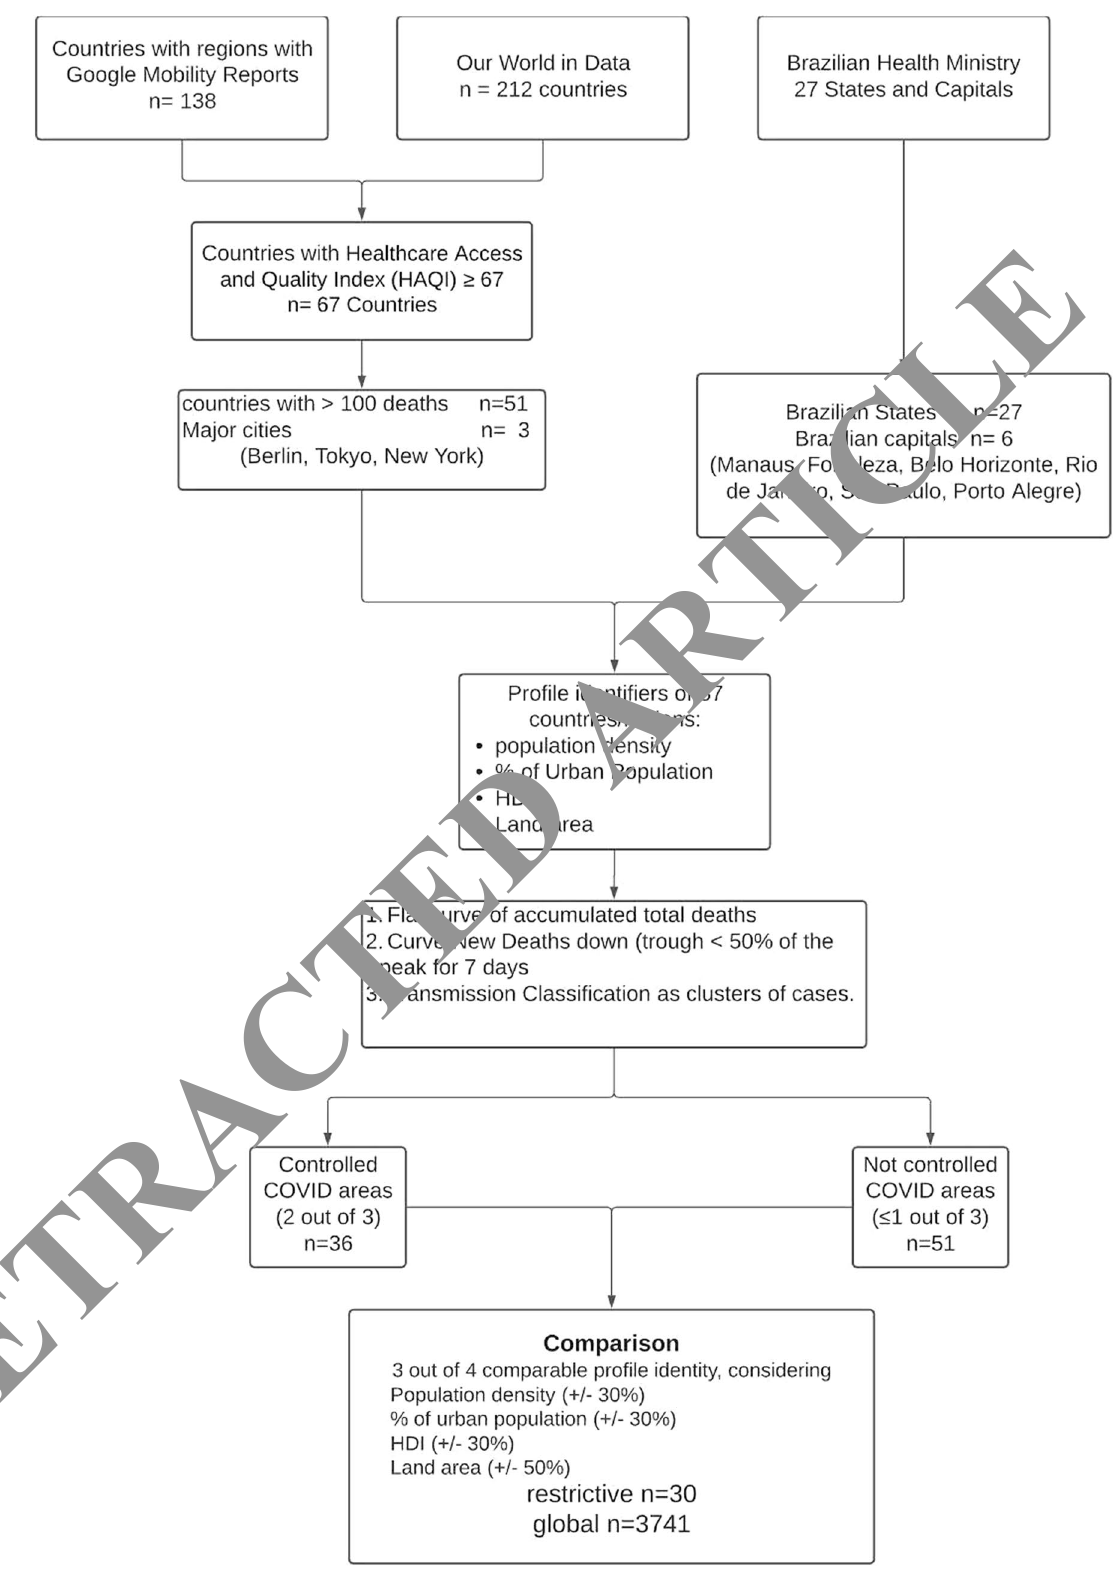
Figure 1. Flow chart of the data setup (further details are in Auxiliary Supplementary Material—Flow